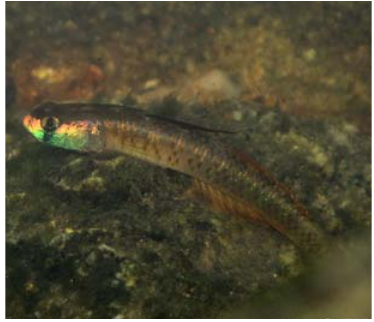
Image 18 Sicyopus zosterophorum (male).